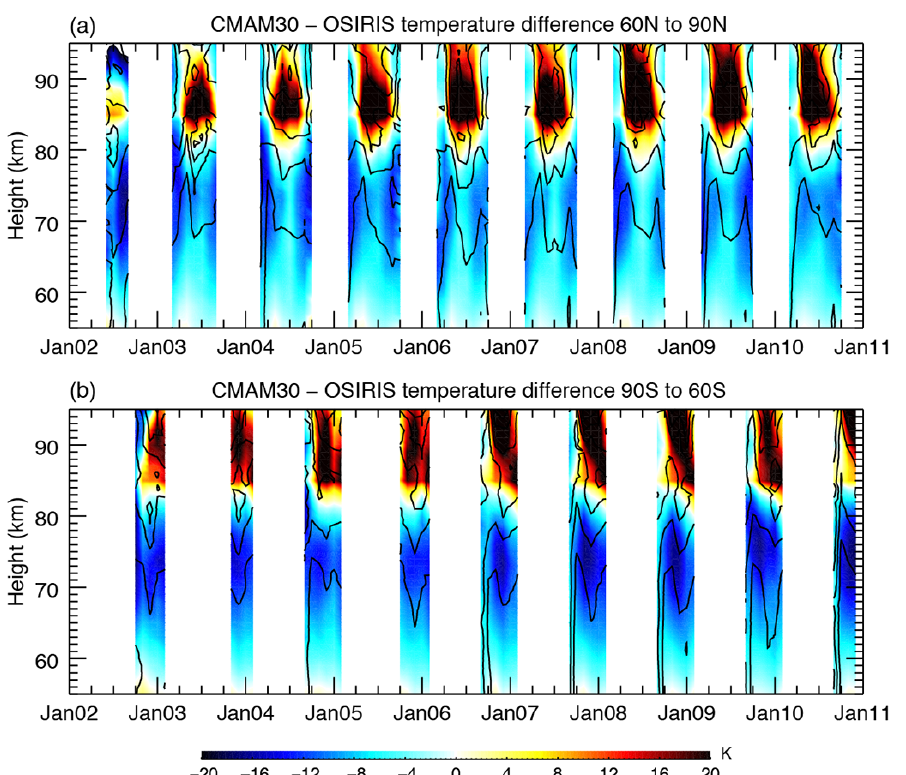
Figure 7. Time series comparison of coincident profiles between CMAM30 temperatures and OSIRIS temperatures derived from the O 2 A-band for 90 ◦ S to 60 ◦ S (a) and 60 ◦ N to 90 ◦ N (b) . Colours indicate the median bias of CMAM30 data. Contours indicate the MAD with contour intervals of